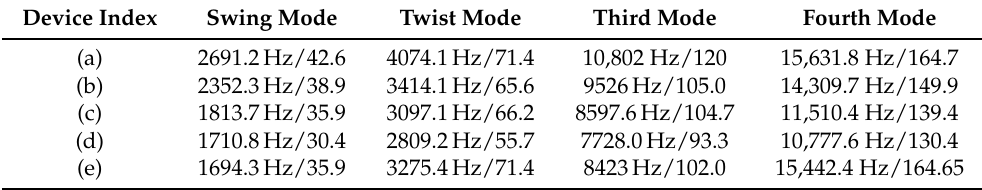
Table 3. Measured resonance frequencies/measured Q factors for different devices and vibration